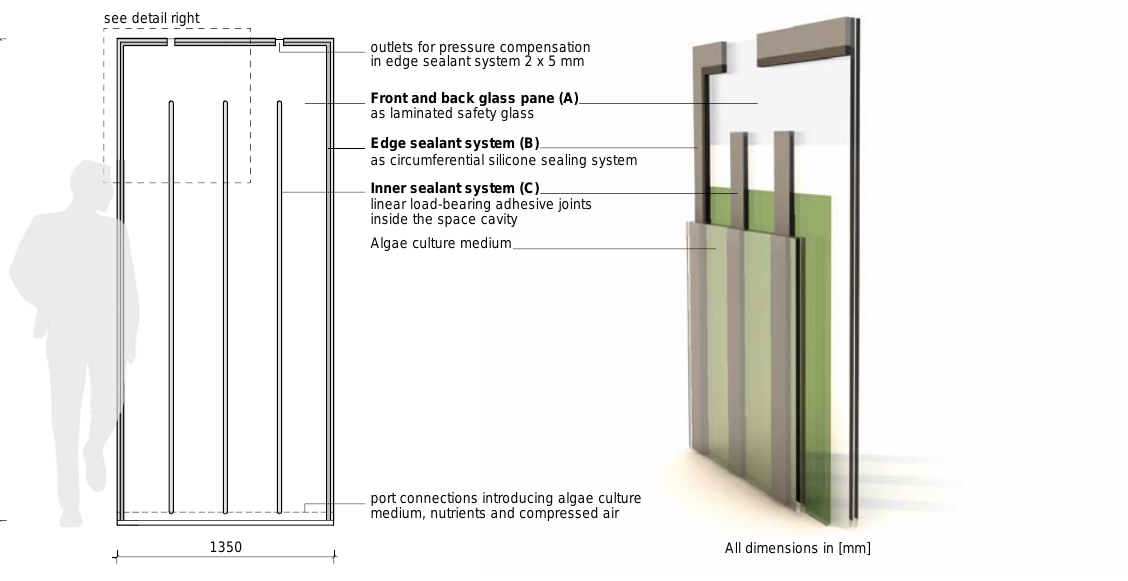
Figure 1: Components of a flat panel photobioreactor for facade